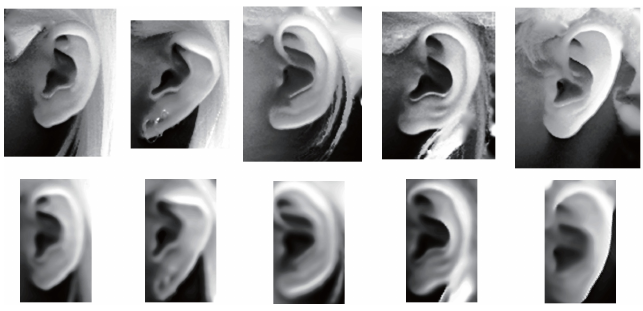
Figure 11. The examples of false recognition utilizing coarsely segmented ear data ( the top row ) and corresponding normalized ear data ( the bottom row ).